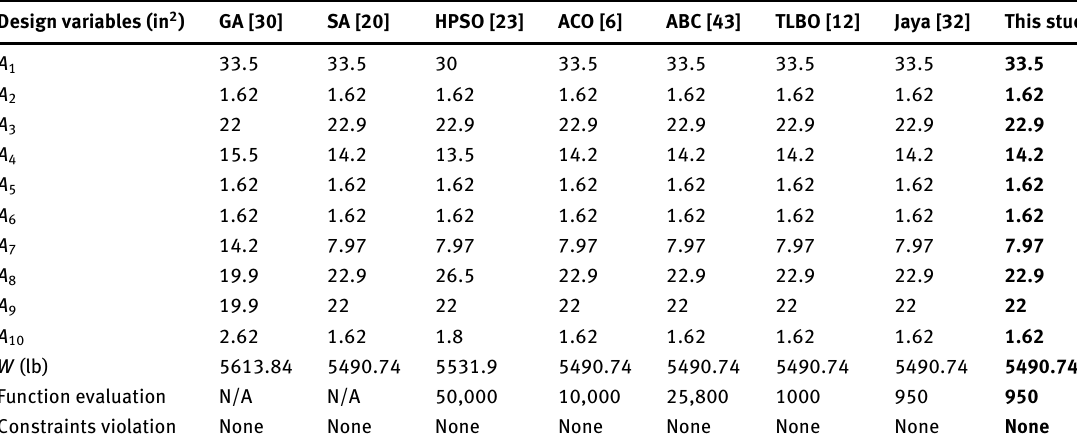
Table 3: Comparison of Optimum Solutions for Planar 10-Bar Truss